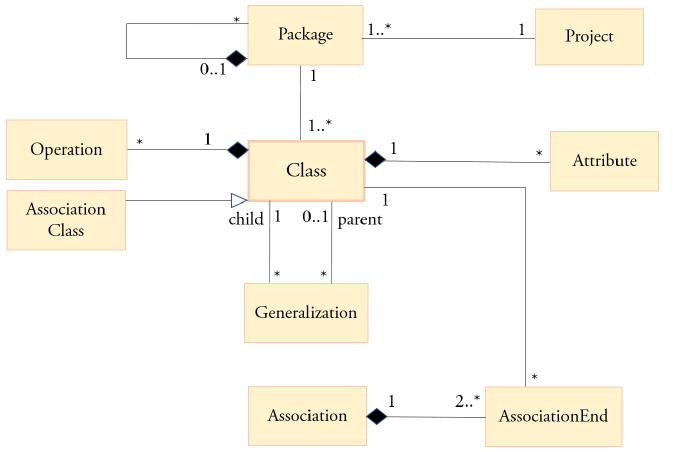
Figure 3. UML metamodel of a metadata repository about class diagrams.